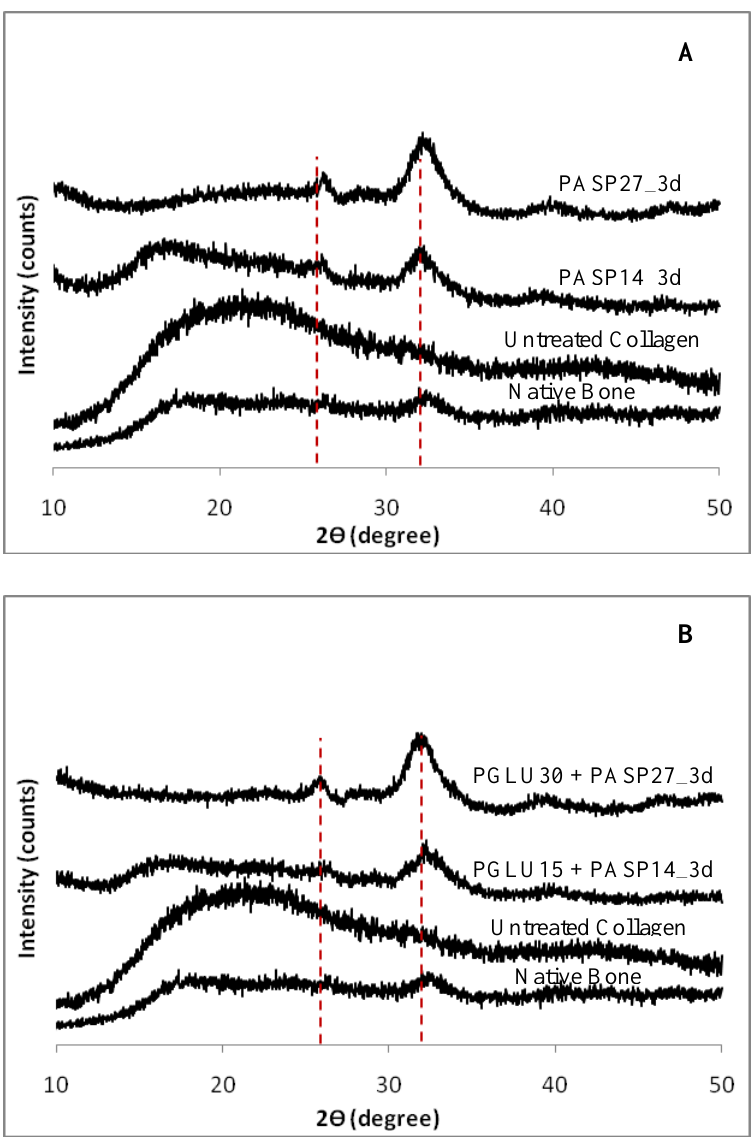
Figure 8. XRD curves of native bone, untreated collagen and PILP mineralized collagen samples using different polymer directing agents. Dashed lines are at 26 and 32